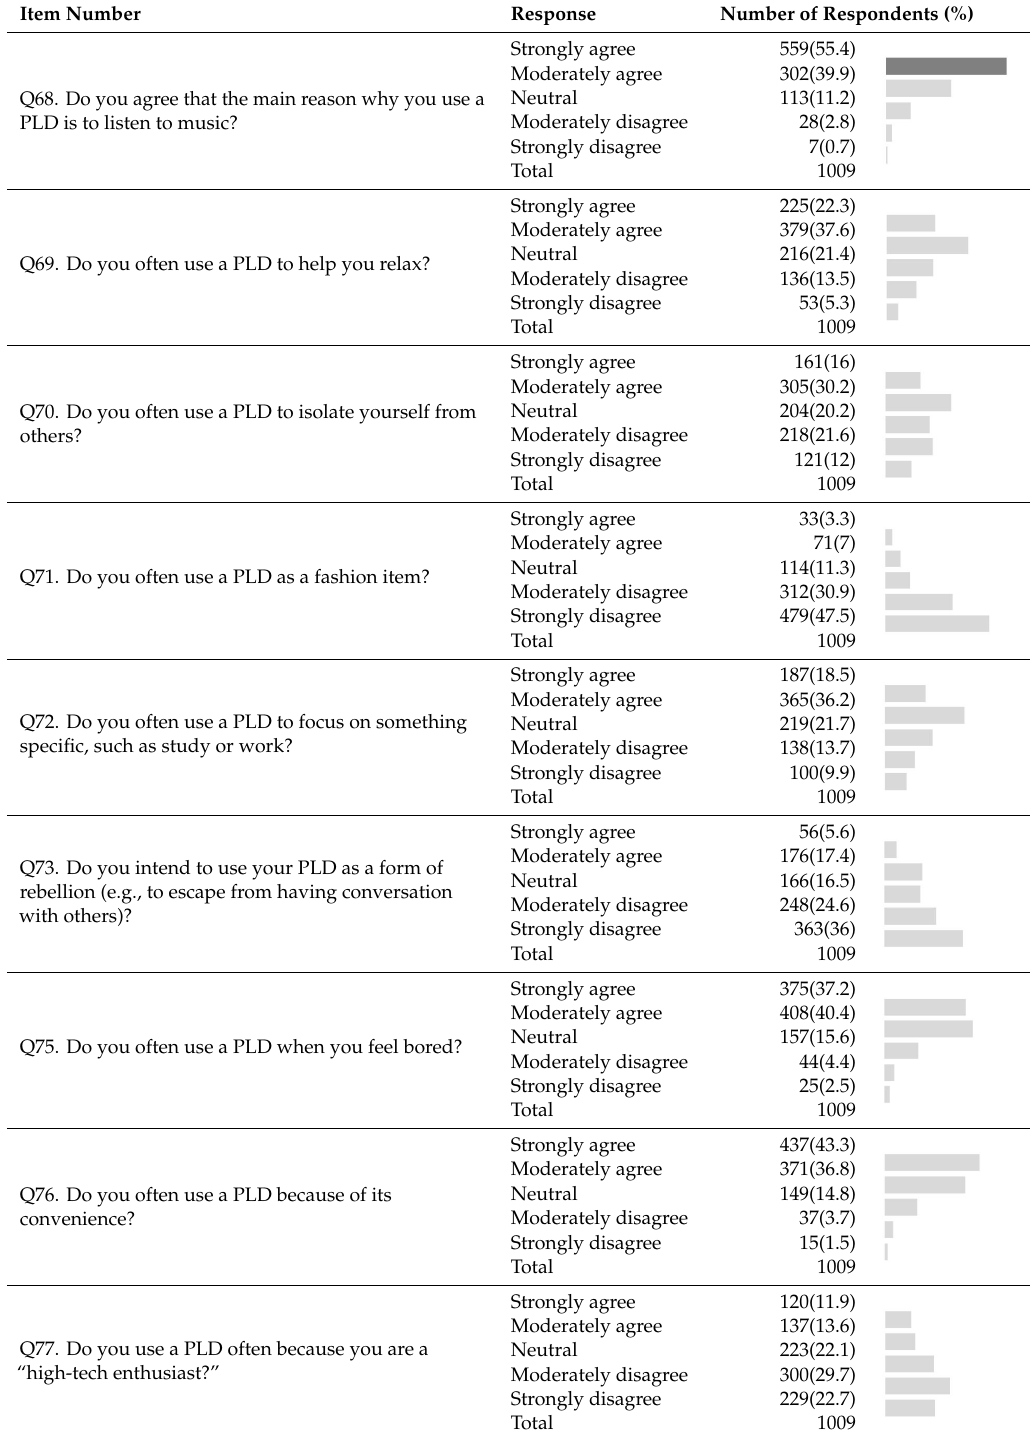
Table A5. Di ff erent reasons for using